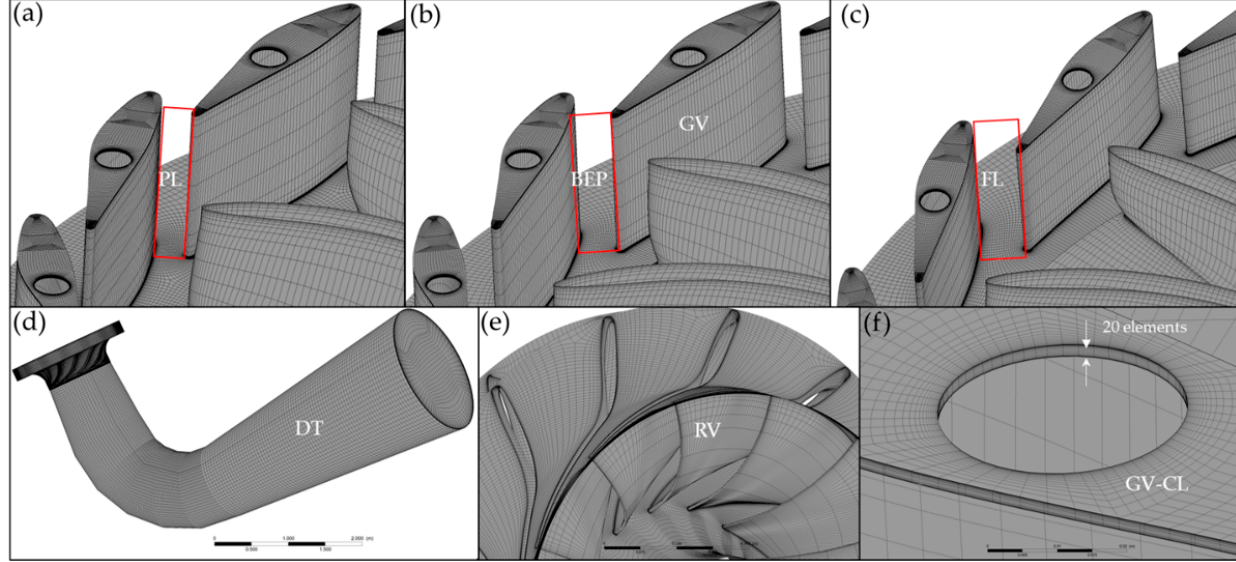
Figure 3. Structural grid for the runner, guide vanes with clearance gaps, and draft tube consisting of 7 million (approx.) elements. ( a ) GV at a partial load; ( b ) GV at the best efficiency point; ( c ) GV at a full load; ( d ) Draft tube; ( e ) Runner; ( f ) Clearance gap.